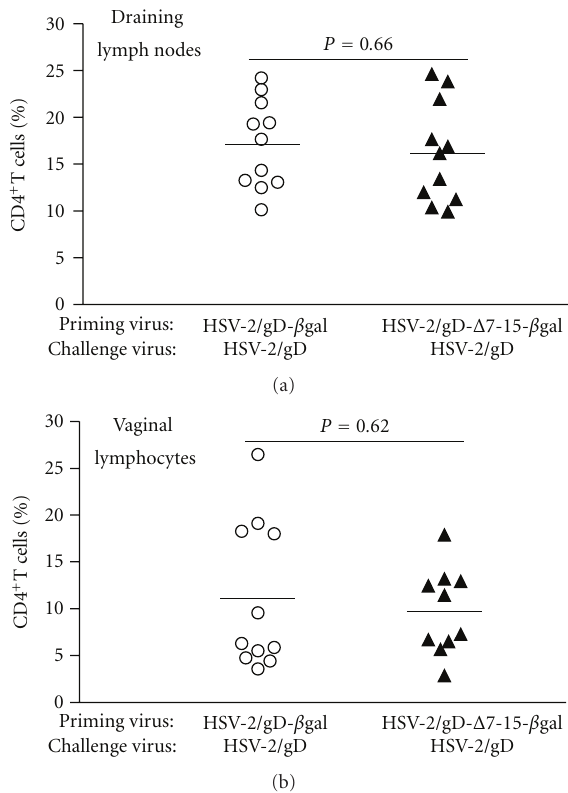
Figure 3: HSV-specific CD8 + T cell frequencies do not di ff er in lymphocytes isolated from (a) draining lymph nodes from groups of mice primed with viruses than can (HSV-2/gD- β gal, left, open circles) or cannot (HSV-2/gD- Δ 7-15- β gal, right, filled triangles) engage HVEM, but are significantly di ff erent at the (b) vaginal mucosa. Symbols show data from individual mice, with the horizontal line designating the mean for each experimental group. Data are pooled from three independent experiments with 3-4 mice per group.